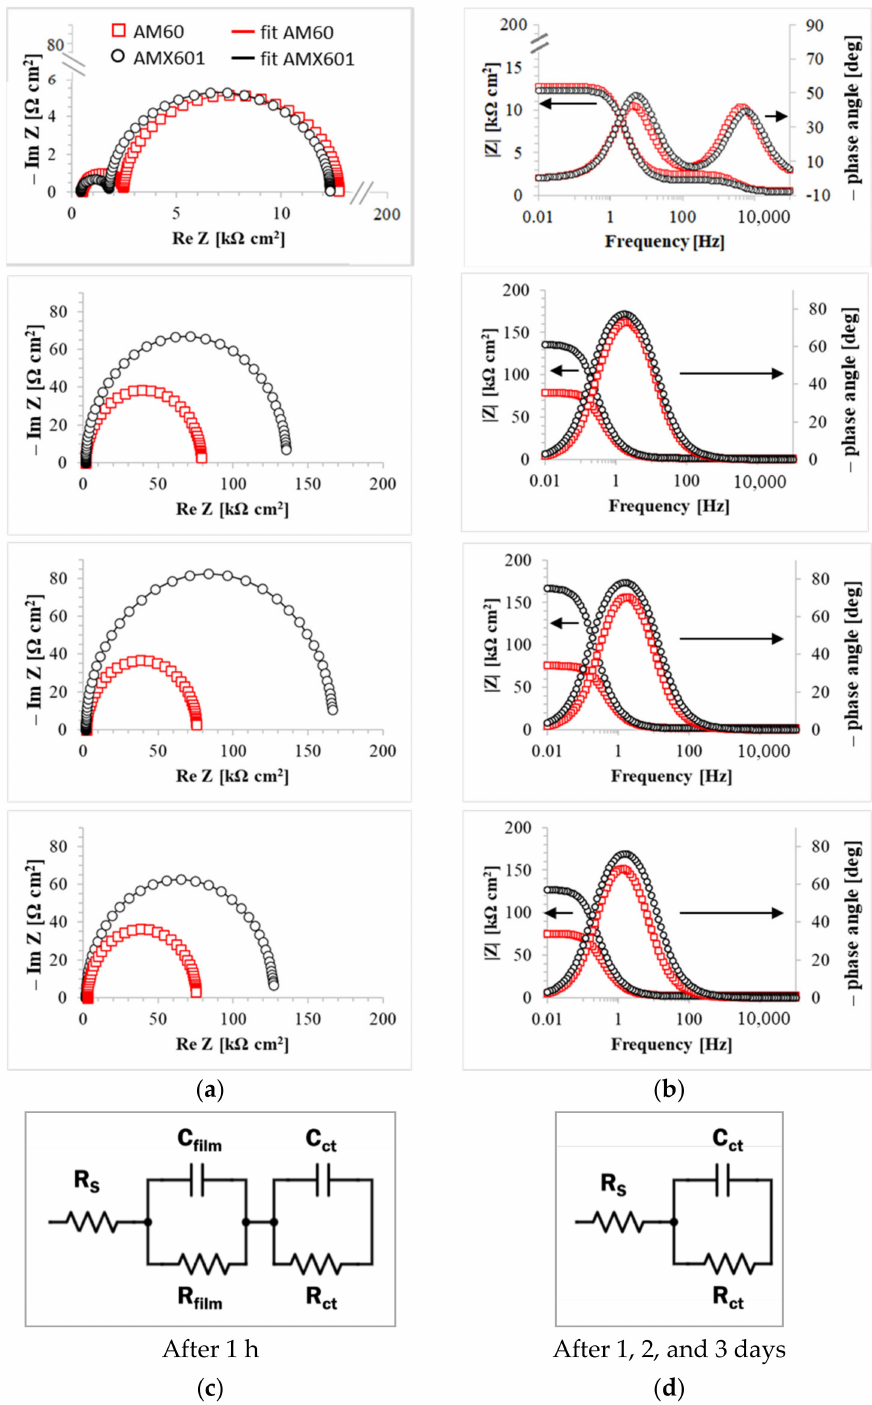
Figure 12. EIS results of AM60 and AMX601 alloys after different immersion periods in NaOH solution (pH ≈ 10.5): ( a ) Nyquist plots; ( b ) Bode plots; ( c , d ) equivalent